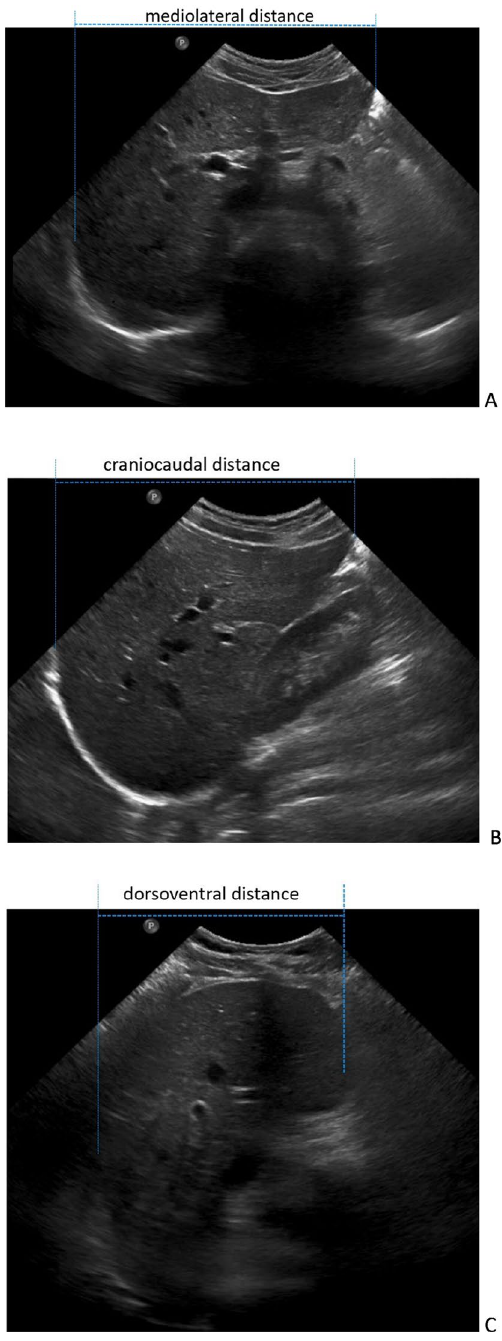
Figure 1. Example of a representative measurement of diameters in ultrasonography. Images were taken during the measurement of maximum diameters in ( A ) mediolateral (USmaxML), ( B ) craniocaudal (USmaxCC) and ( C ) dorsoventral direction